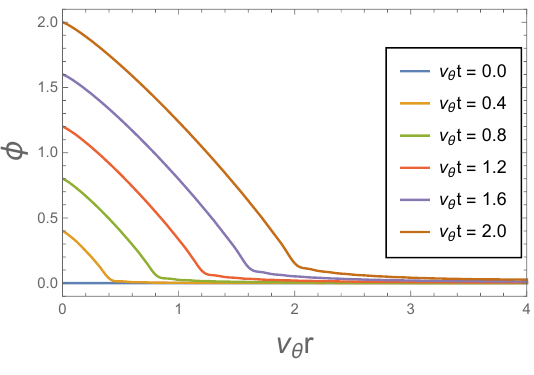
Figure 1 . The plot of φ for v θ r 0 = 4 . 0 and α = 0 . 7 , where the sum is taken up to n = 50